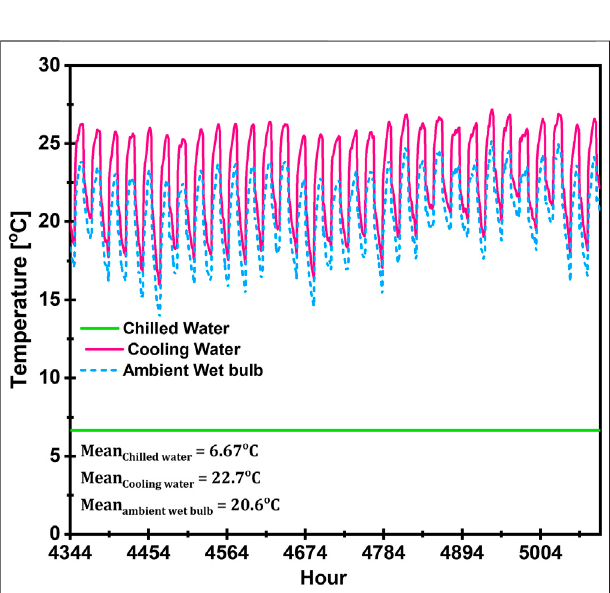
FIGURE 10 | The variations in cooling tower outlet water temperature and wet bulb